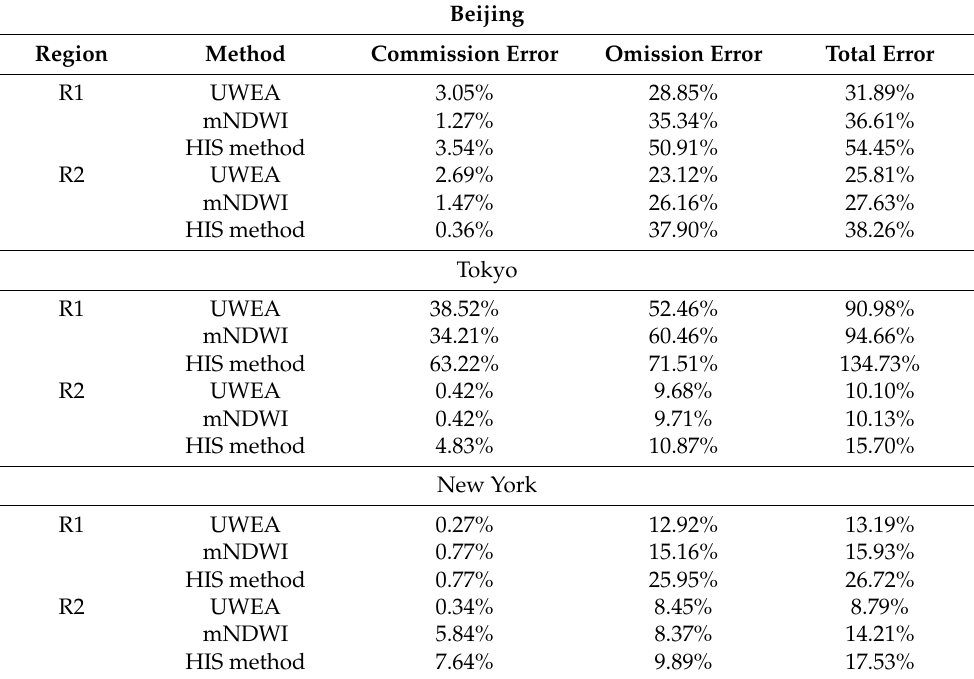
Table 2. The classification accuracy of the three methods for the validation